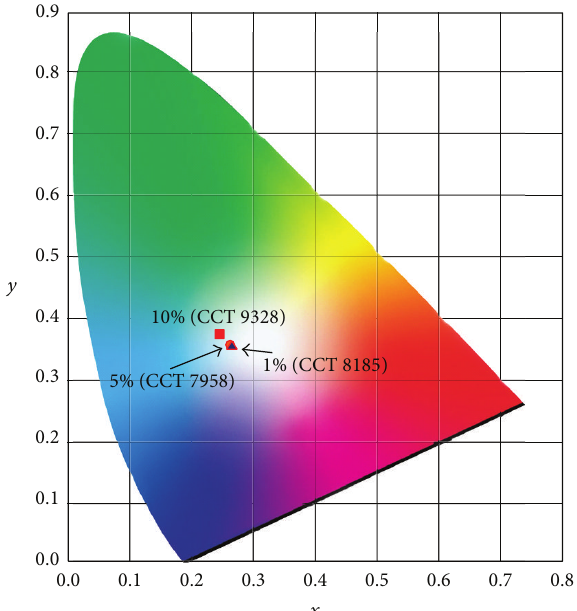
Figure 6: Chromaticity coordinates of the ZnO:YAG films at 1, 5, and 10wt% on Si substrate.